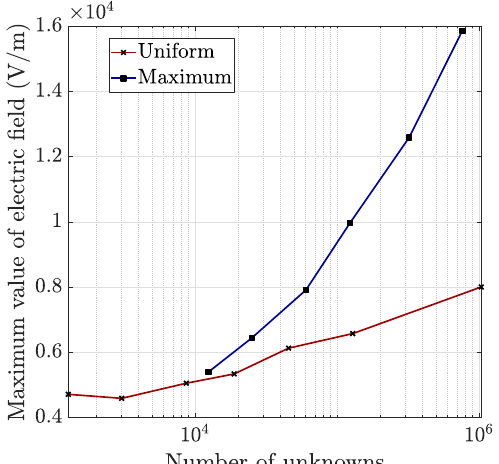
Figure 23. Representation of the singularity with different levels of h